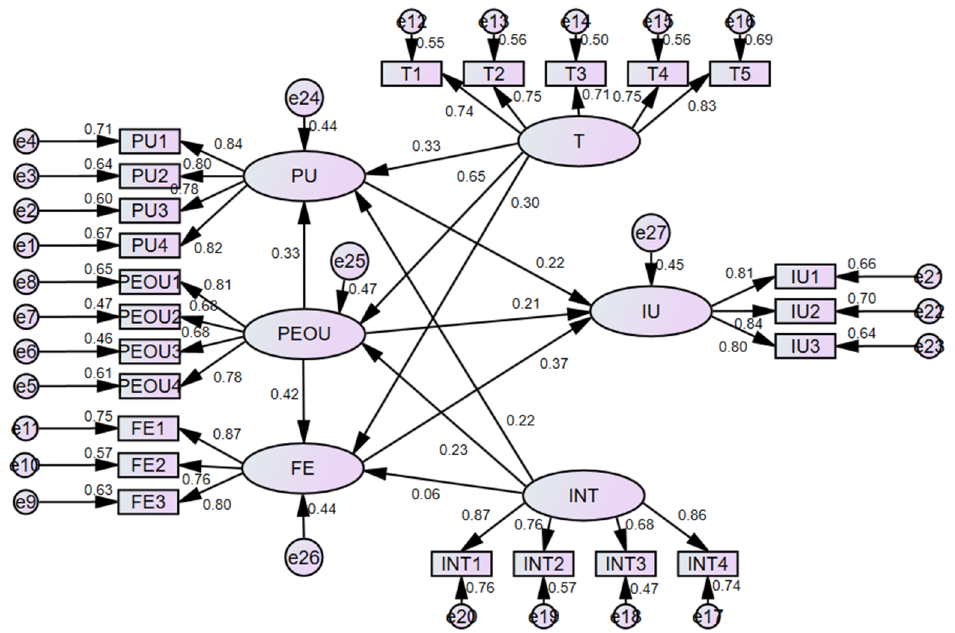
Figure 3. The standardized path estimation for structural equation